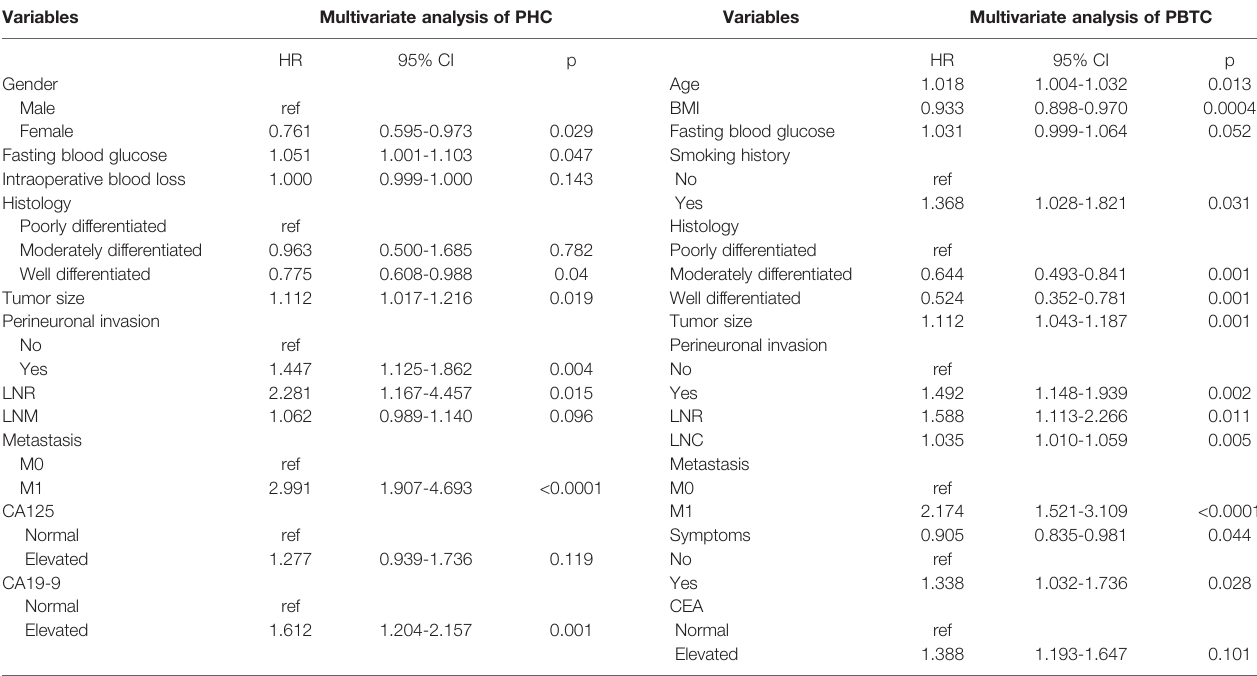
TABLE 4 | Multivariate Cox regression analysis of prognostic factors for PHC and PBTC patients with curative-intent surgical resection.